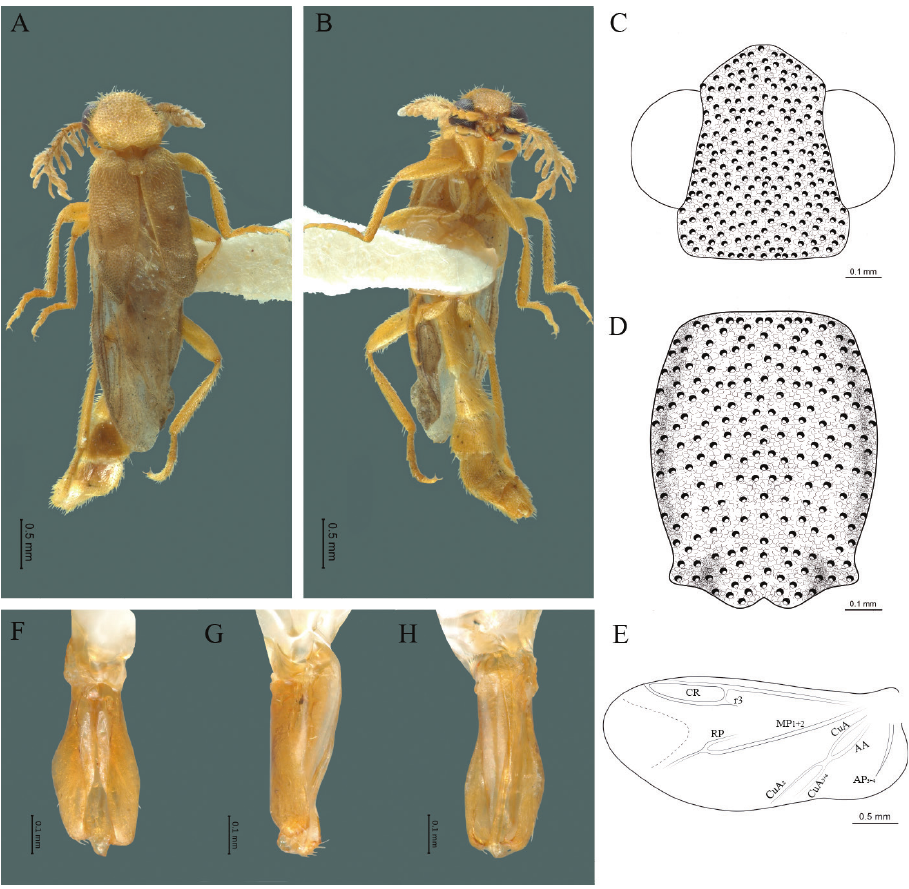
Figure 23. Cenophengus pallidus Schaeffer, 1904, male. Habitus: A dorsal B ventral C head dorsal D pronotum dorsal E hind wing. Wing venation: CR = Radial Cell; r3 = radial 3 vein; RP = Posterior Radial vein; MP1+2 = Posterior Median vein; CuA = Cubital vein; AP = Posterior Anal vein. Aedeagus: F dorsal view G lateral view H ventral